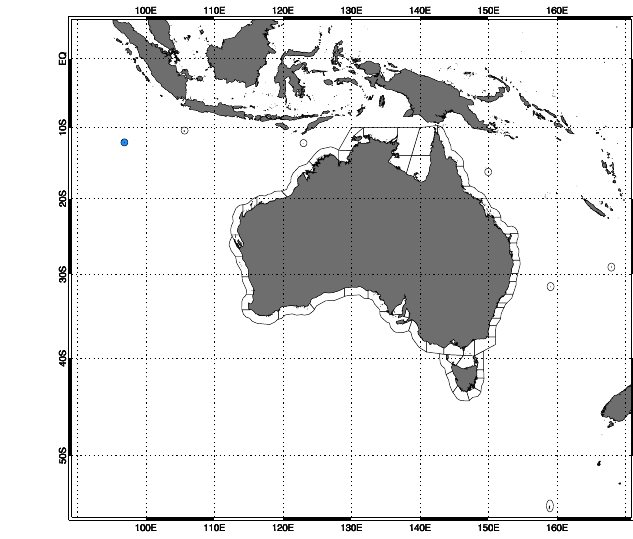
Fig. 5. Desired warning scheme for the Sumatra 2005 event. No marine or land threats were assigned to any coastal zone.